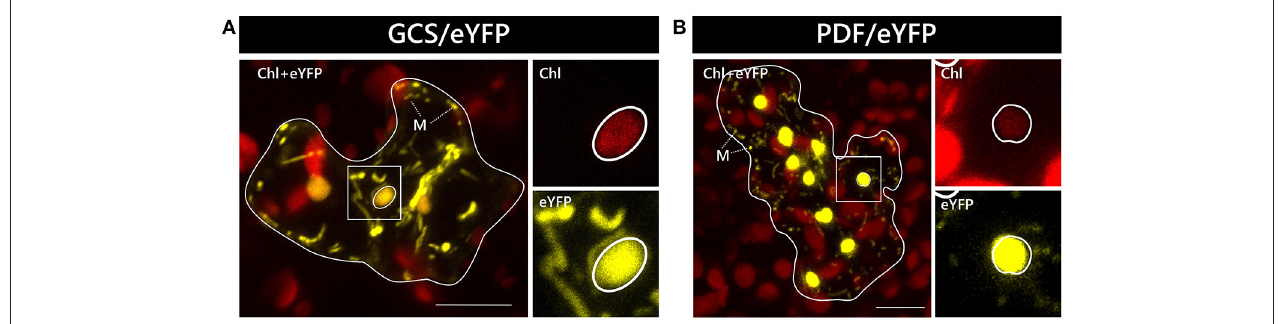
FIGURE 1 | Dual localization of GCS/eYFP and PDF/eYFP after particle bombardment of Arabidopsis thaliana leaves. The coding sequences of GCS/eYFP (A) and PDF/eYFP (B) were transiently expressed under the control of the CaMV 35S promoter after particle bombardment of leaf epidermis cells of Arabidopsis thaliana and analyzed by confocal laser scanning microscopy. Representative cells showing dual localization of the candidate proteins in both mitochondria and chloroplasts are presented as overlay images of the chlorophyll channel (displayed in red ) and the eYFP channel (displayed in yellow ). The borders of the transformed cells are depicted by a continuous white line . The strong chlorophyll signals in the background are derived from the larger chloroplasts of untransformed mesophyll cells underneath the epidermal cell layers. The squares highlight areas of the transformed cells that are shown in higher magnification separately for the chlorophyll channel and the eYFP channel, as indicated. The position of representative plastids of each transformed cell is encircled for better visualization. Representative mitochondria are marked ( M ). The scale bars correspond to 10 µ m.